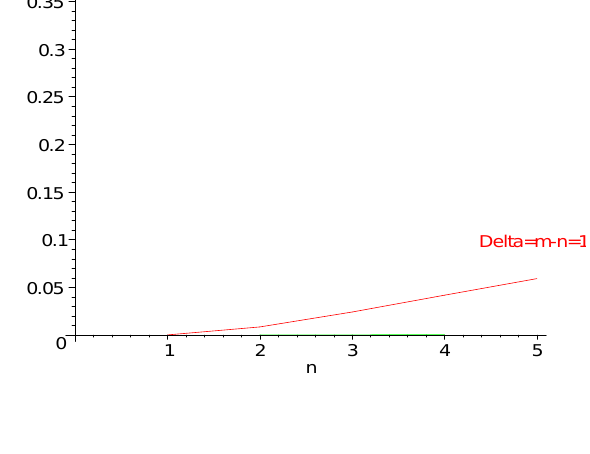
≡ P r ( D ( n,m ) > 0) , depending on ∆ = m − n > 0 , for different Figure 6. Value of P W W ). Traces corresponding to ∆ = 2 and ∆ = 3 are significantly lower than values of n ( α = 1 2 0 . 01 and, thus, are not visible in the